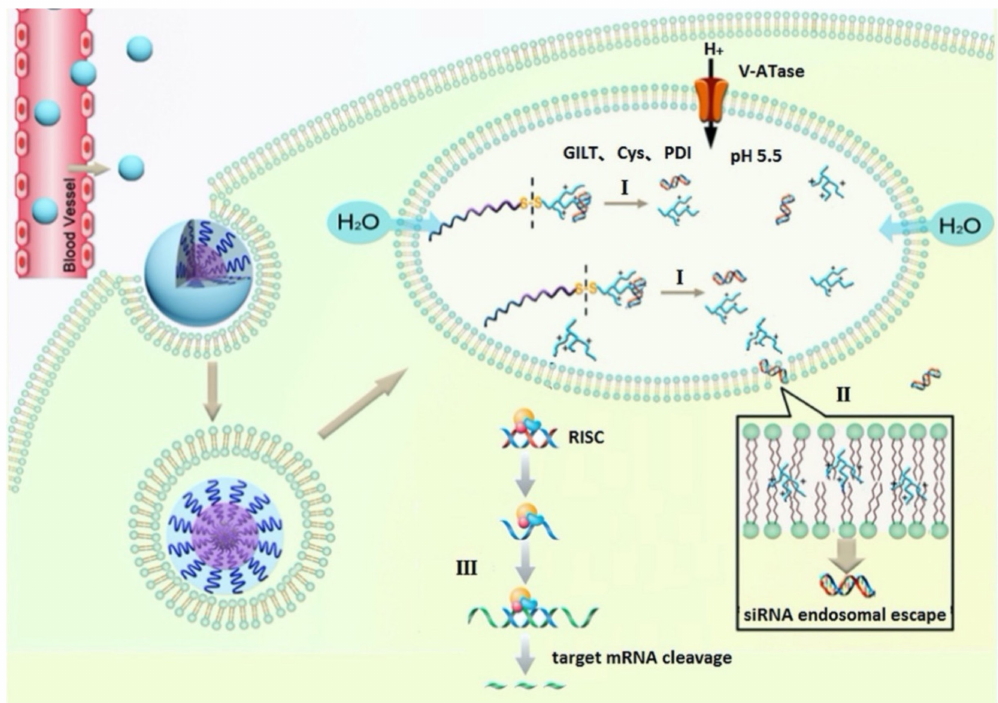
Figure 5. Schematic illustration of the intracellular trafficking of mPEG-b-PLA-Phis-ssPEI and siRNA complexes. After internalized by tumor cell, ( I ) the complexes rapidly disassemble to release siRNA and free polyethylenimine (PEI) molecules in response to the acidic and reductive microenvironment, ( II ) efficiently escape from the endosome, facilitated simultaneously by cleaved PEI chains inducing membrane destabilization, the “proton sponge effect” of polyhistidine and polyethylenimine, as well as the relative small size of after disassembly, ( III ) achieve efficient gene silencing by cytosolic target mRNA cleavage. Adapted with permission from [179]. Copyright 2018